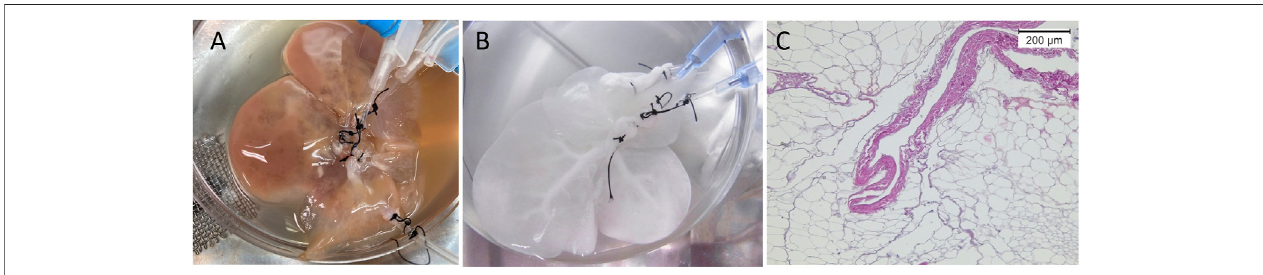
FIGURE 2 | Rat liver decellularization. (A) The liver during perfusion of detergents, (B) transparent DLM after completion of the decellularization protocol, (C) DLM histology showing preservation of the native honeycomb appearance of the liver ECM.